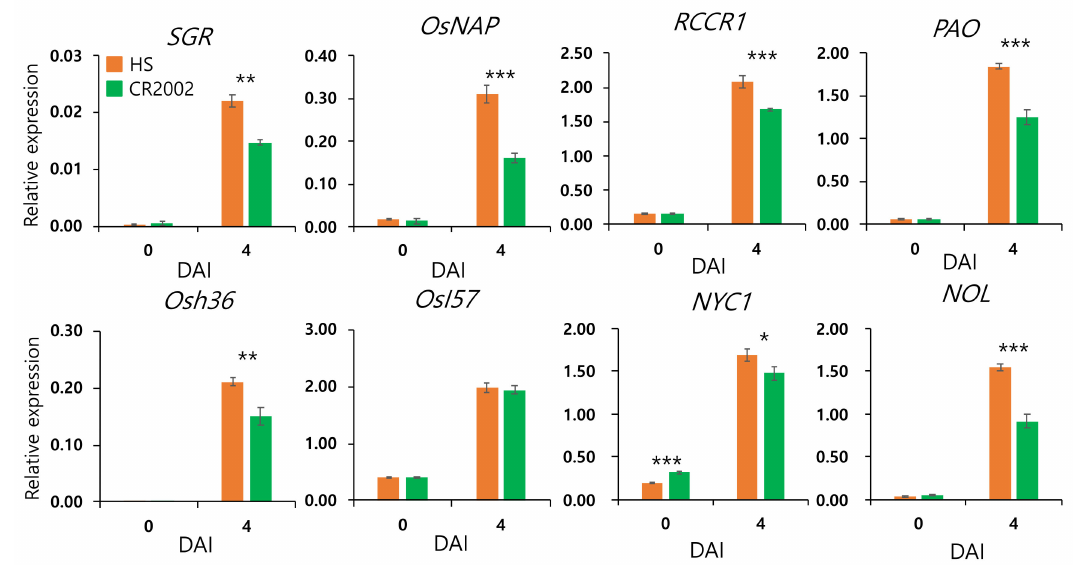
Figure 3. Expression of senescence-associated genes and chlorophyll degradation genes in Hwaseong and CR2002. qRT-PCR was conducted to determine the transcript level of genes. OsUBQ5 was used for normalization. Error bars indicate the standard deviation of three replications. *, **, and *** indicate significant di ff erence at p < 0.05, p < 0.01, and p < 0.001 based on Student’s t -test, respectively. DAI: days after